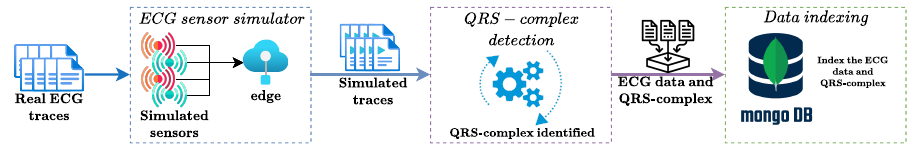
Figure 4. Conceptual representation of the structure used to perform the case study of the experimen- tal